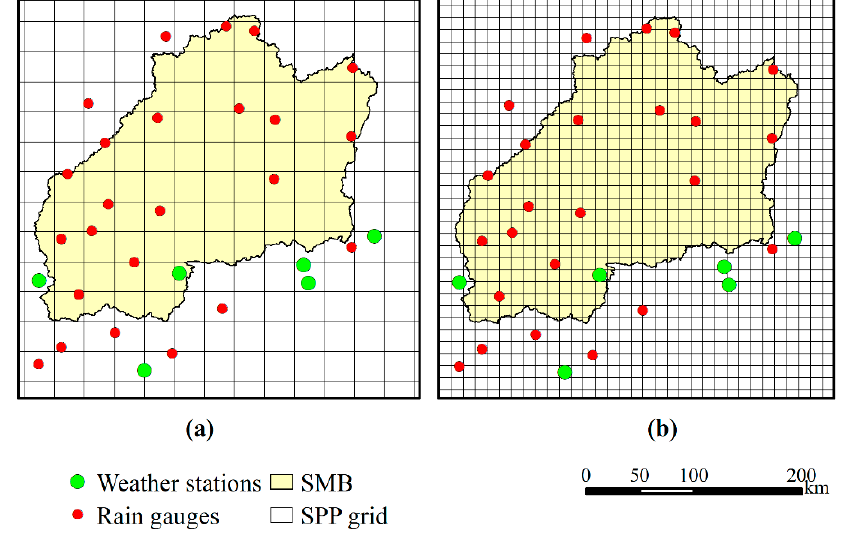
Figure 2. Spatial distribution of weather stations and rain gauges in relation to TRMM Multi-satellite Precipitation Analysis (TMPA) ( a ) and Integrated Multi-Satellite Retrievals for GPM (IMERG) ( b ).